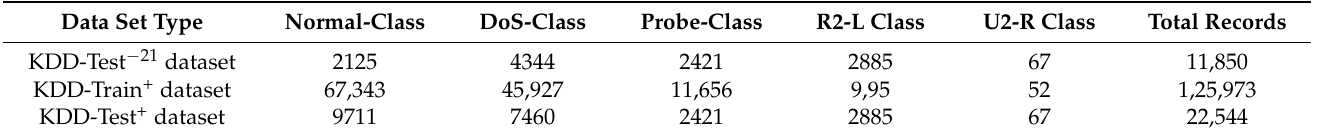
Table 7. Multi-class classification (NSL-KDD)